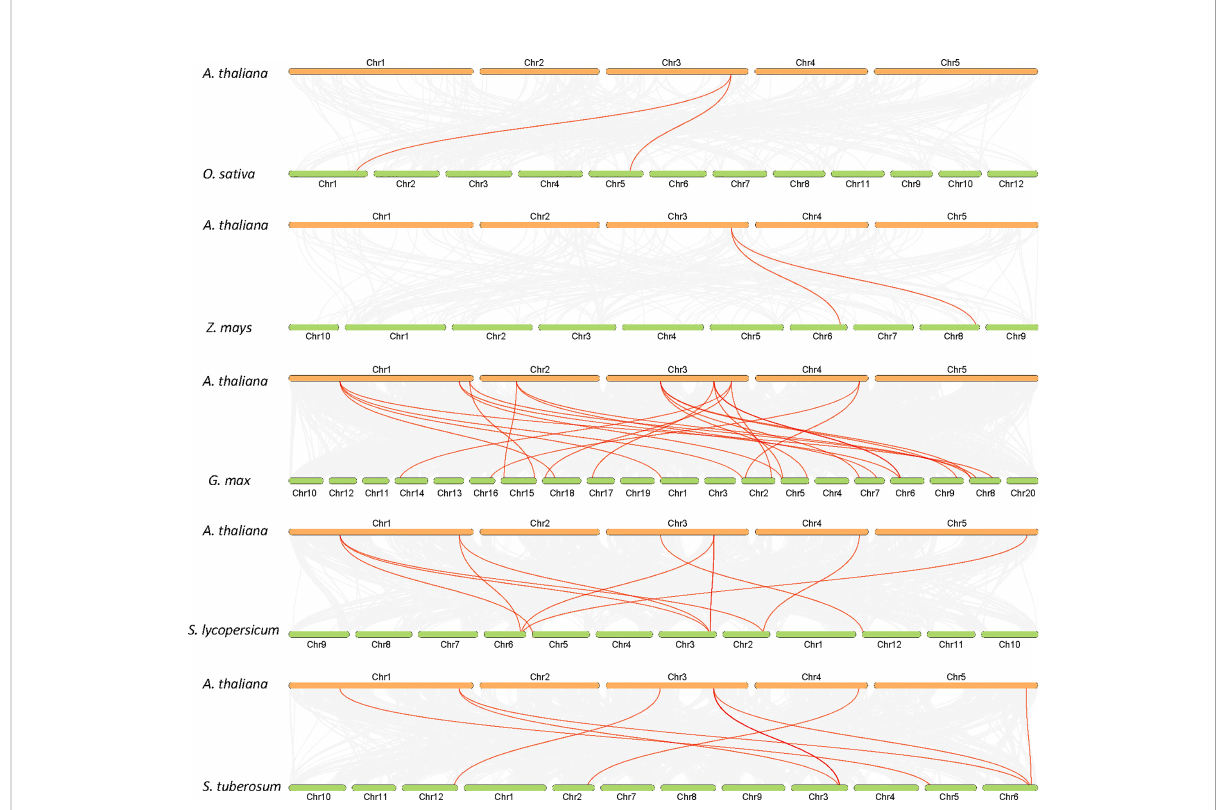
FIGURE 3 Synteny analysis of ALDH genes in Arabidopsis and other plants ( G. max , O. sativa , S. lycopersicum , Z. mays and S. tuberosum ). Gray lines in the background indicate collinearity blocks, whereas syntenic ALDH genes are shown as red